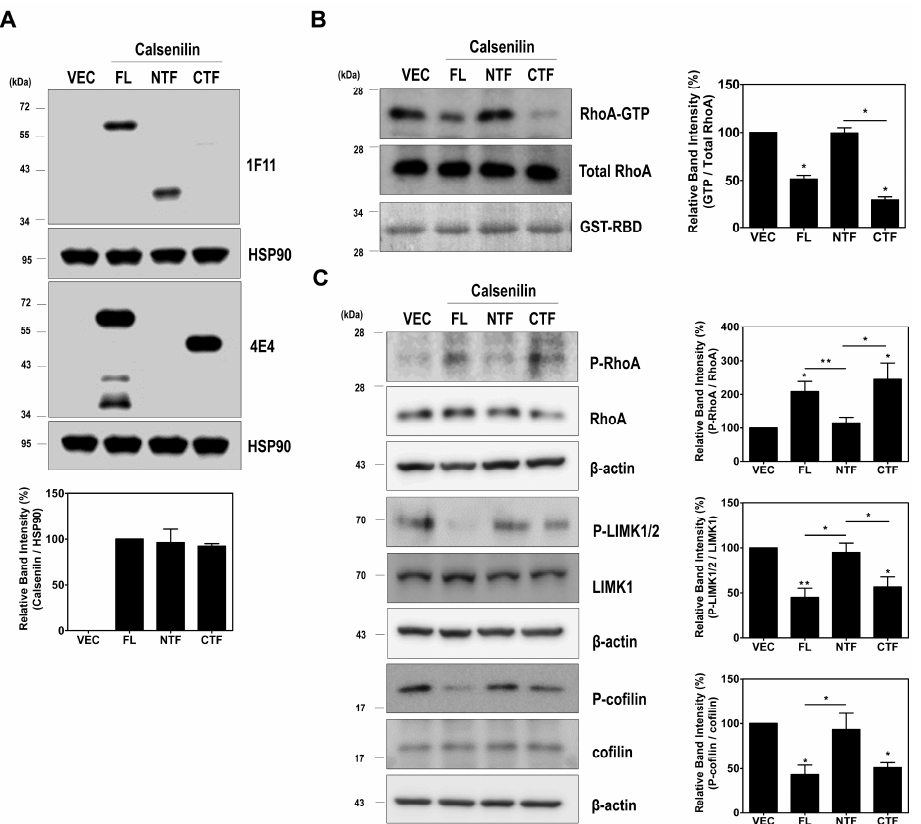
Figure 5. Calsenilin-CTF inactivates RhoA. ( A ) The expression level of calsenilin was determined by Western blotting with anti-1F11 and anti-4E4 antibodies; ( B , C ) RhoA-GTP levels and phosphorylation of RhoA and RhoA-mediated signaling proteins in PC12 cells expressing VEC, calsenilin-FL, or truncated fragments (NTF or CTF) were detected and analyzed by Western blotting. The intensities of the bands in each panel were measured and quantified for each group, and the values are expressed as the mean ± SEM of three independent experiments. Statistical differences were determined by one-way ANOVA test with Tukey’s post hoc test ( n = 3, * p < 0.05; ** p < 0.01).